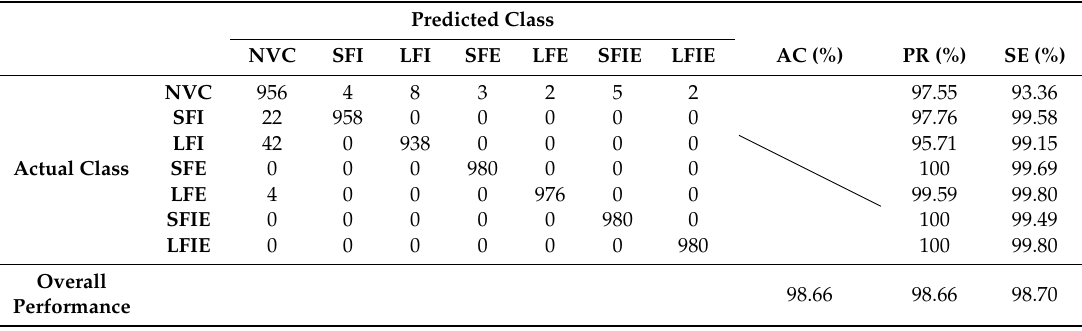
Table 3. Confusion matrix of seven valve clearance states of first trial with the low-level noise.